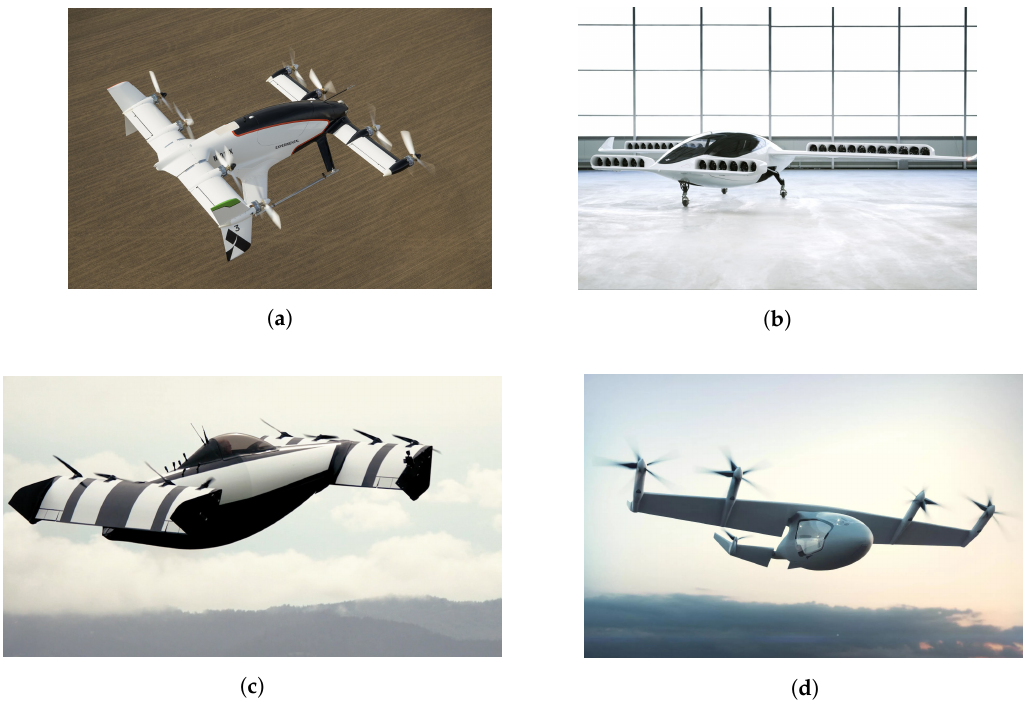
Figure 12. Examples of VTOL aircraft demonstrator vehicles for personal transportation. ( a ) Airbus Vahana, by Airbus Urban Mobility. ( b ) Lilium Jet, by Lilium GmbH. ( c ) BlackFly, by Opener. ( d ) eVTOL, by